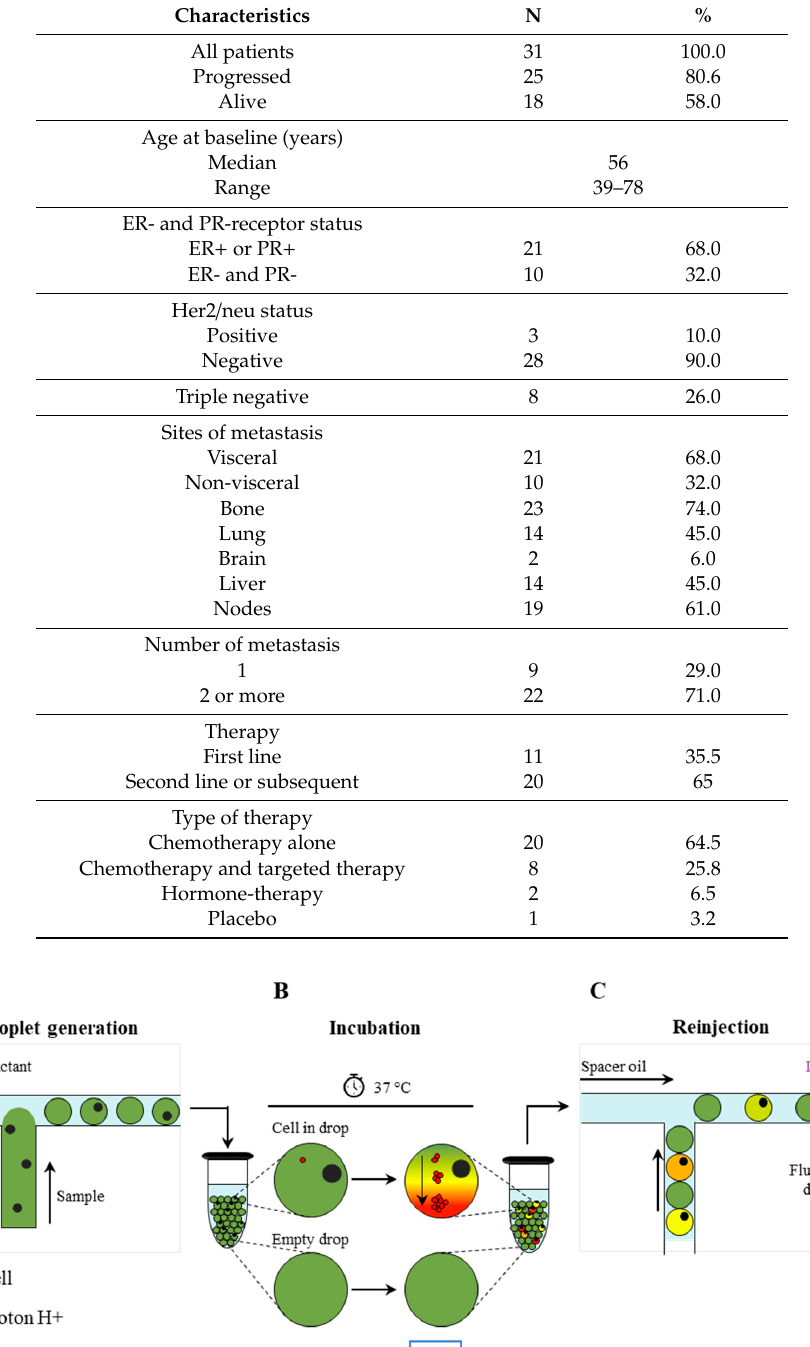
Table 1. Patient and tumor characteristics.